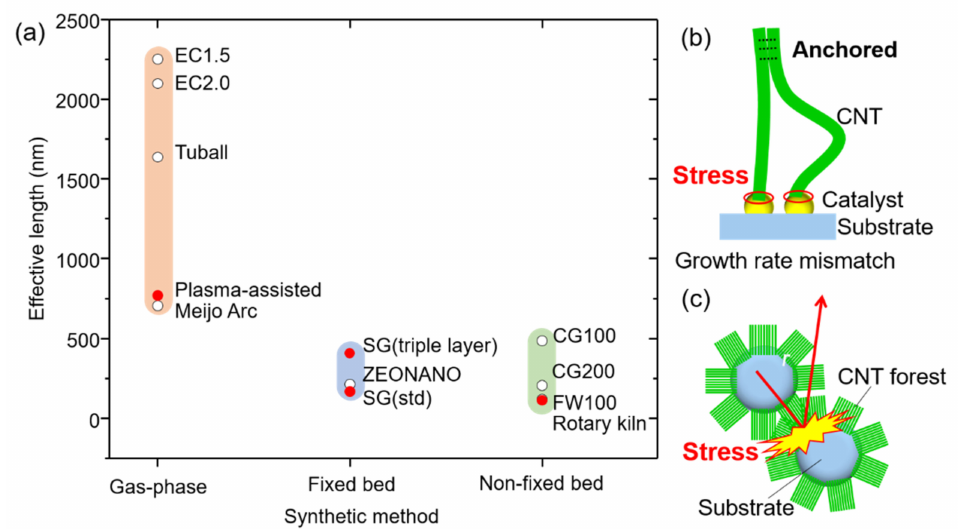
Figure 3. ( a ) Effective lengths of CNTs classified by synthesis methods. Schematic illustrations showing ( b ) the stress loaded to the catalyst-CNT interface by the growth rate mismatch between CNTs and ( c ) additional stress by collision between substrates during CNT